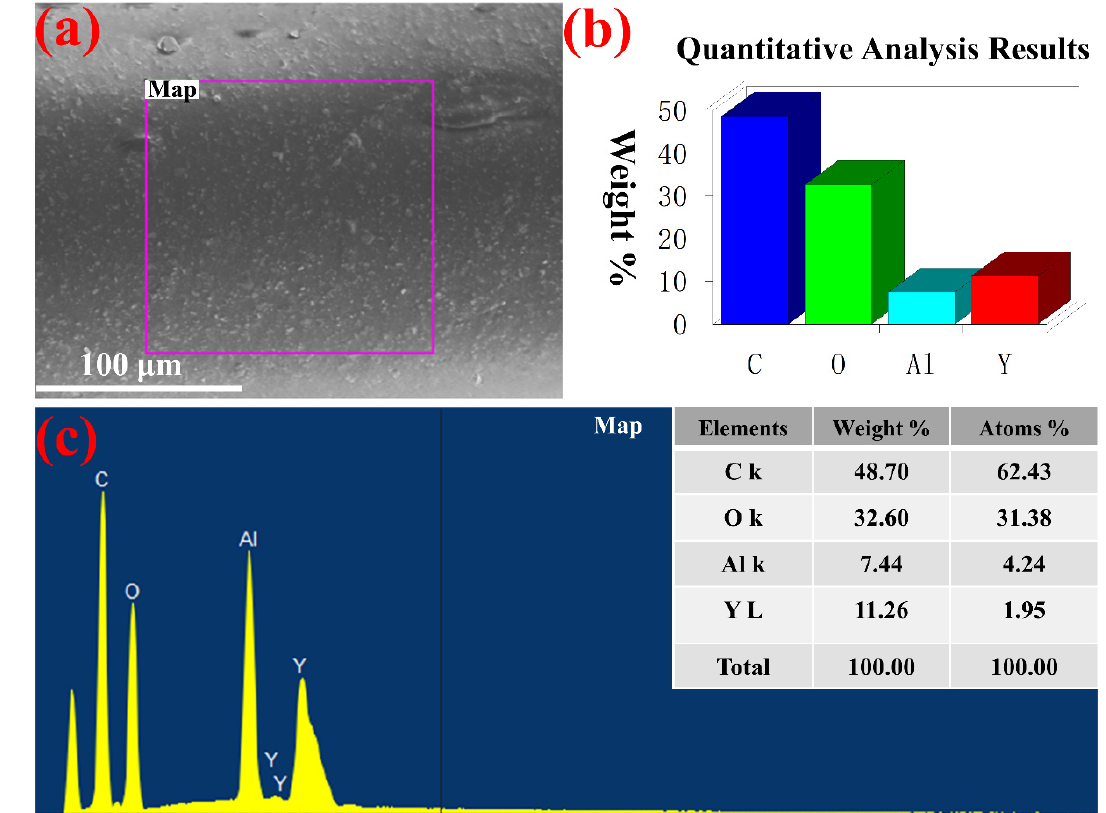
Figure 5. EDS analysis of the ceramic fiber (TPU ‐ 95A#, the mass ratio of TPU ‐ 75A# to ceramic powder = 4:6): ( a ) surface SEM image from surface scanning of ceramic fiber, ( b ) histogram of elemental quantitative analysis, ( c ) plot of types and intensities of elements detected (embedded table: the mass and atomic specific gravity of the four elements).